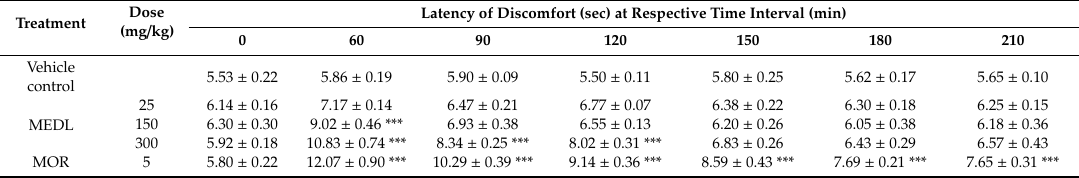
Table 1. E ff ects of MEDL on the hot plate test in mice. Mice were treated with vehicle (10 mL / kg, p.o.), MEDL (25, 150, 300 mg / kg, p.o.), or MOR (5 mg / kg, p.o.). Data expressed are the mean ± SEM of reaction time (sec) of six mice. Statistical analysis was performed using 2–way ANOVA followed by Tukey’s multiple comparisons test. *** p ≤ 0.001 Dose Latency of Discomfort (sec) at Respective Time Interval Treatment (mg / kg) compared to vehicle control group.